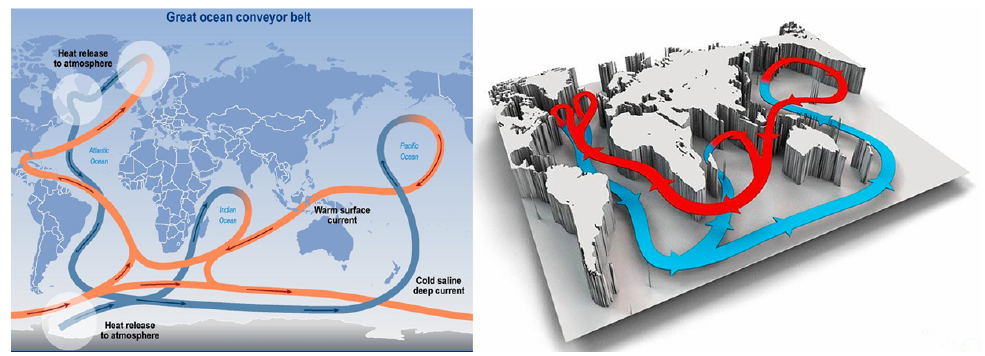
Figure 12. Great ocean conveyor belt